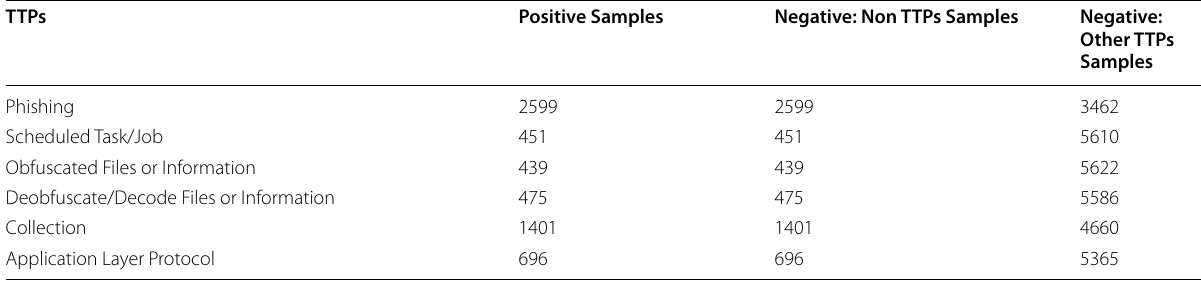
Table 7 The positive and negative sample number of six TTPs